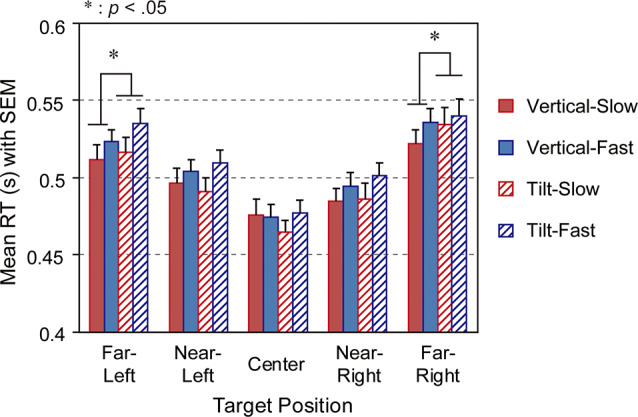
Mean reaction times (RTs) at each target position for types of speed and pillar. The error bars represent the SEM. SEM, standard error of the mean.